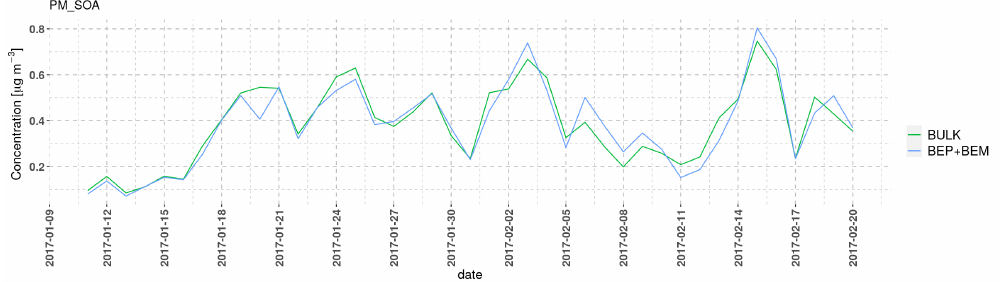
Figure 14. Average daily concentrations of PM secondary organic aerosol for BULK simulations (green) and BEP+BEM simulations